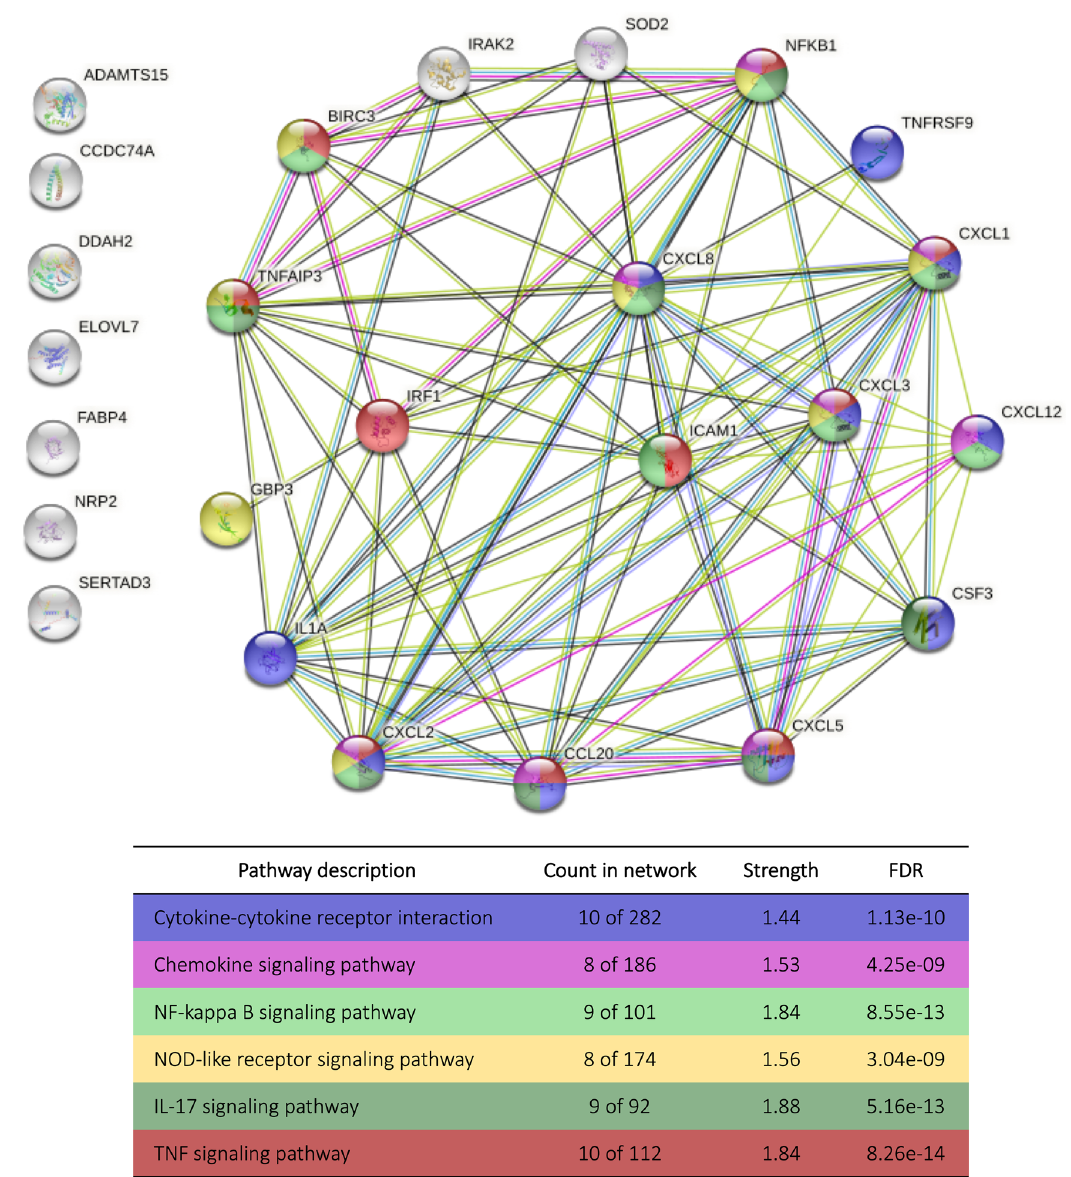
Figure 3. In silico enrichment analysis of 25 proteins encoded by DEGs of the CCs from patients with endometriosis I/II. Note Protein-coding gene = identified outside the nodes. Nodes = proteins (inside the nodes is the protein 3D structure). The colors of the nodes represent the pathways in which they were enriched. White nodes are the second shell of interactions. Edges = protein–protein associations. There are 86 edges. The white nodes on the left side, without edges, have no protein–protein associations. FDR, False Discovery Rate. Created in STRING. Permanent link: https:// versi on- 11-5. strin gdb. org/ cgi/ netwo rk? netwo rkId= bAvx7 jSmic